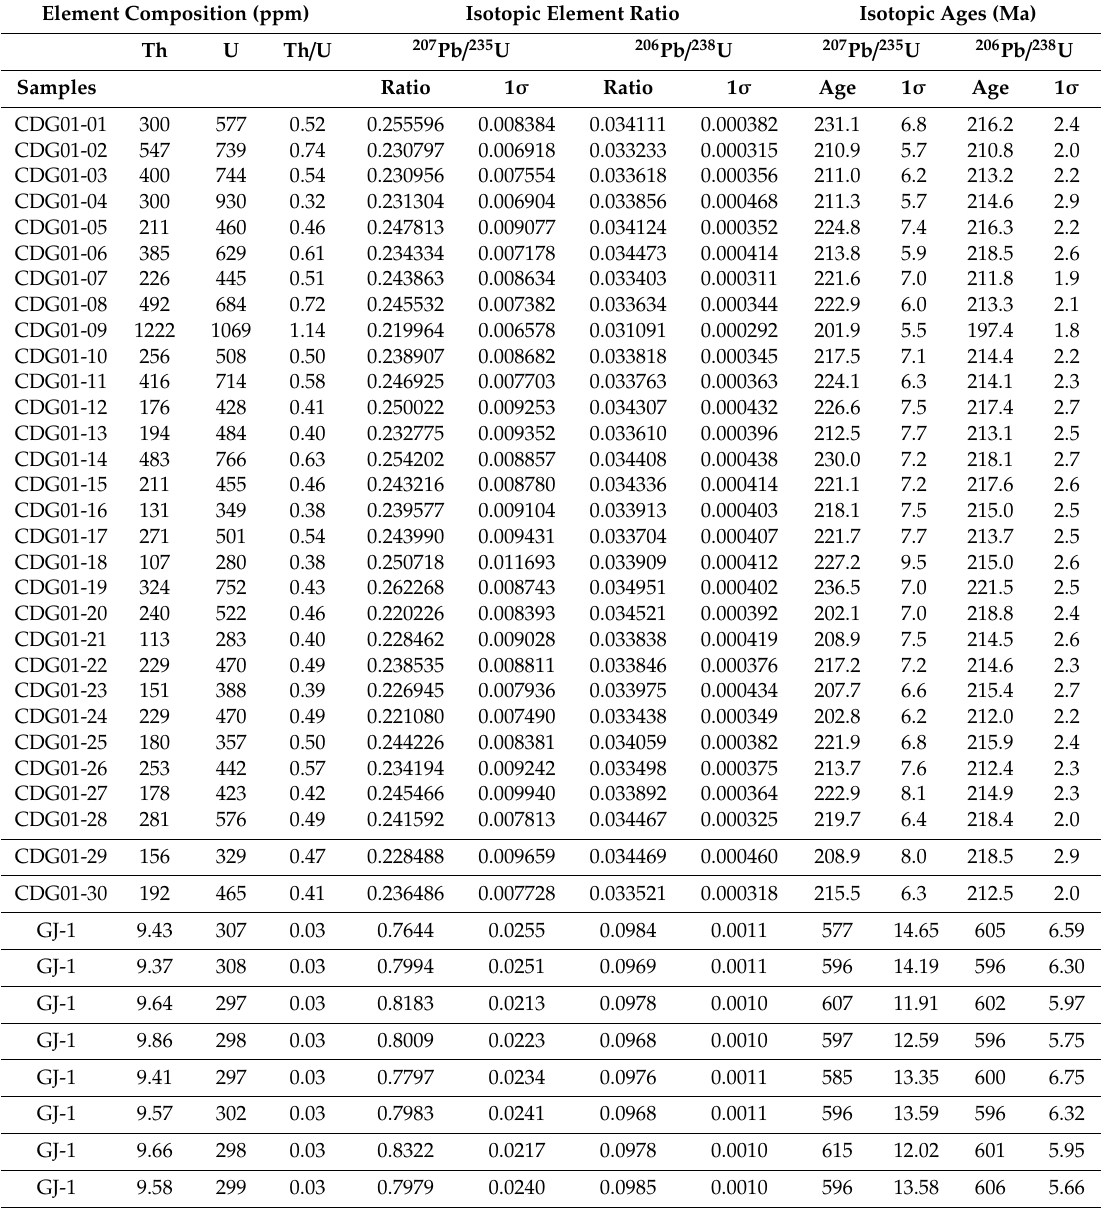
Table 1. U-Pb isotopic compositions and ages of zircon grains from Changdagou granodiorite